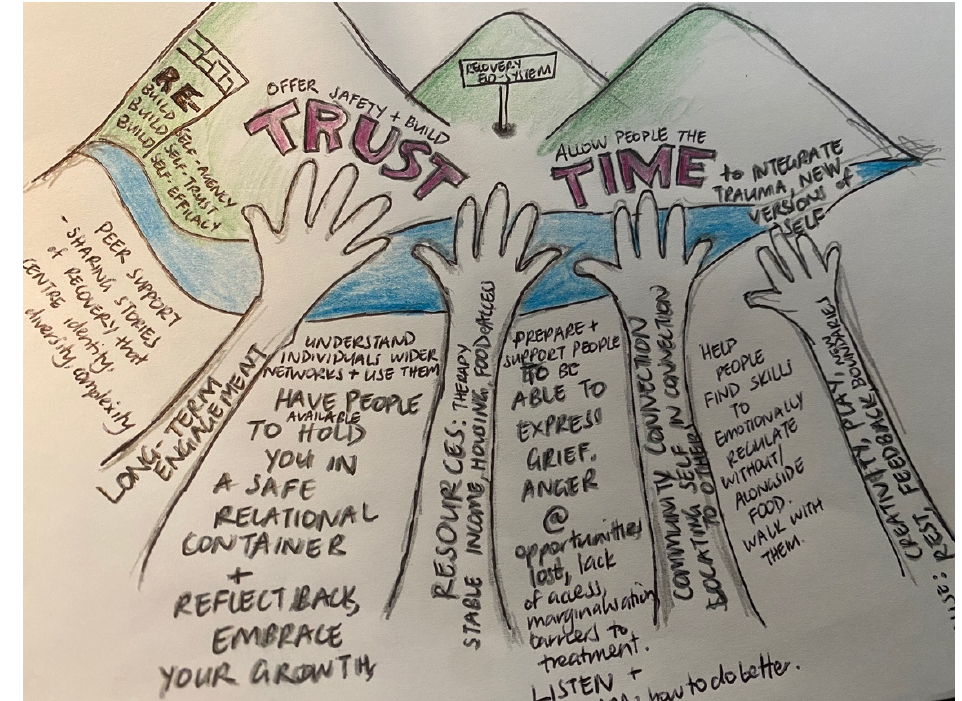
Figure 1. Drawing by participant Lorraine.